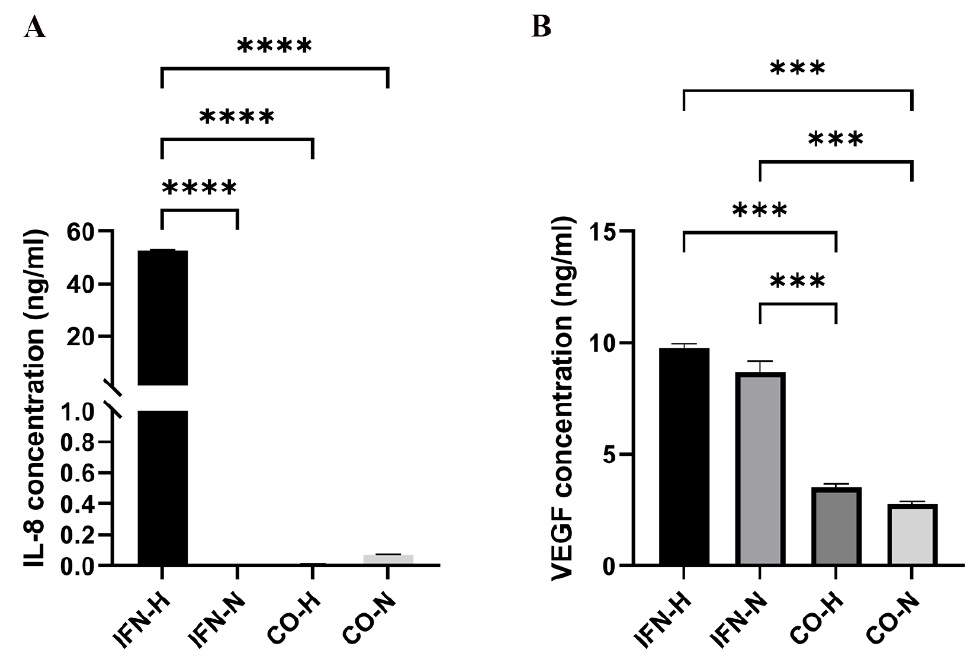
Figure 4. Quantification of IL-8 ( A ) and VEGF ( B ) protein concentration in secretomes from iMSCs pre-conditioned with IFN- γ under hypoxic and normoxic conditions. Values represent means ± SEM values from three independent experiments (*** p < 0.001; **** p < 0.0001).